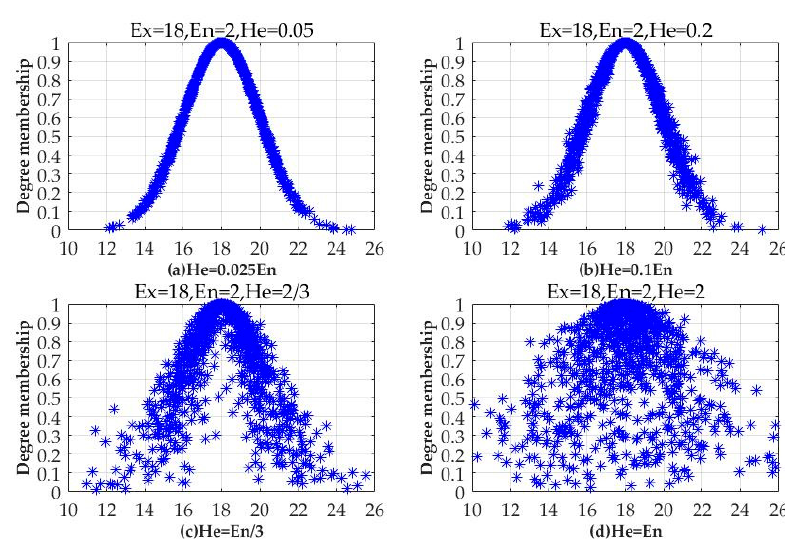
Figure 2. Effect of entropy change on cloud image. Figure 2. E ff ect of entropy change on cloud image.